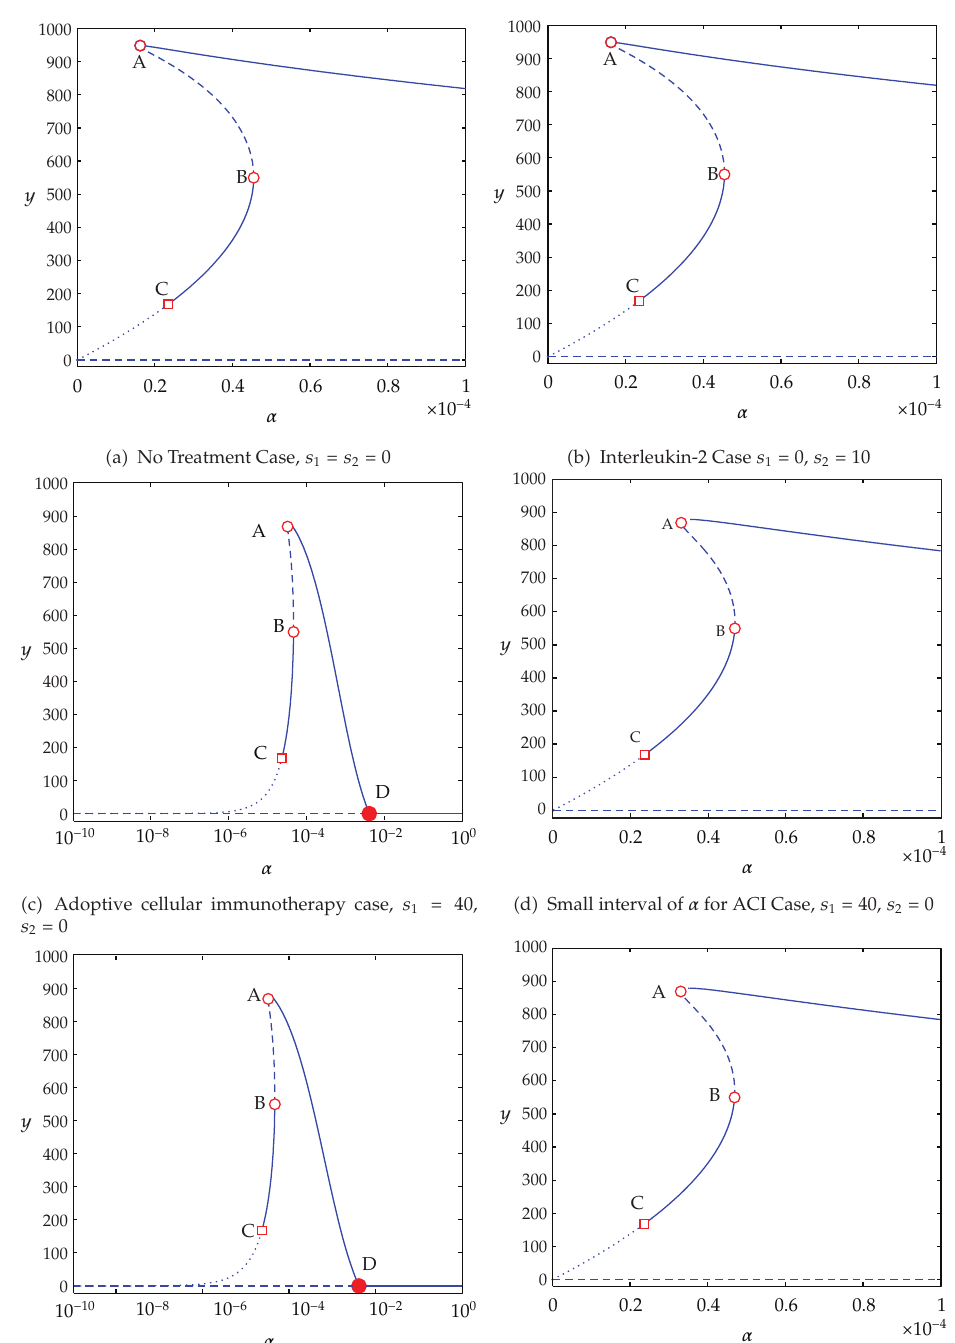
Figure 4: shows the bifurcation diagrams for the bilinear model (cid:4) 2.5 (cid:5) for the parameter α : (cid:6) — (cid:7) represents the stable equilibrium, (cid:6) - - - (cid:7) represents the unstable equilibrium, (cid:6) ··· (cid:7) is the stable limit cycles, while (cid:6) ◦ (cid:7) is the saddle node bifurcation. (cid:6) • (cid:7) is the transcritical bifurcation and (cid:6) (cid:2) (cid:7) the supercritical Hopf bifurcation. The values of parameters are given in Table